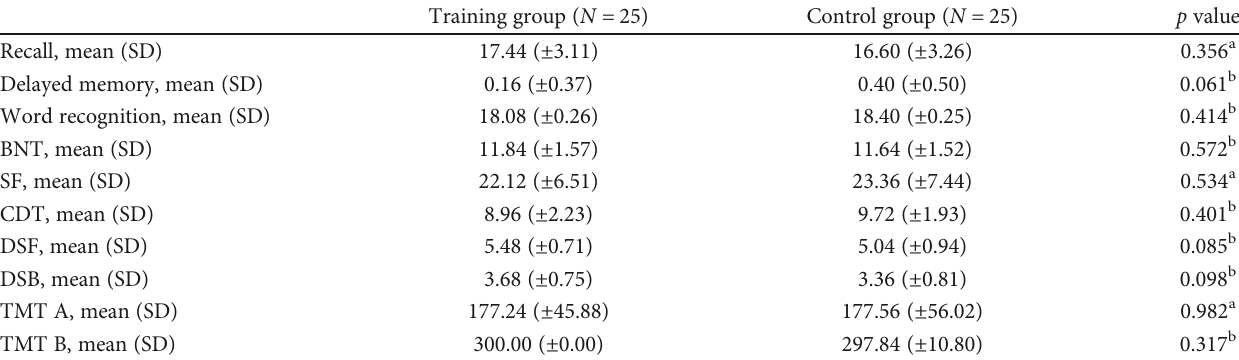
Table 2: Neuropsychological test scores of the training and control groups at baseline.